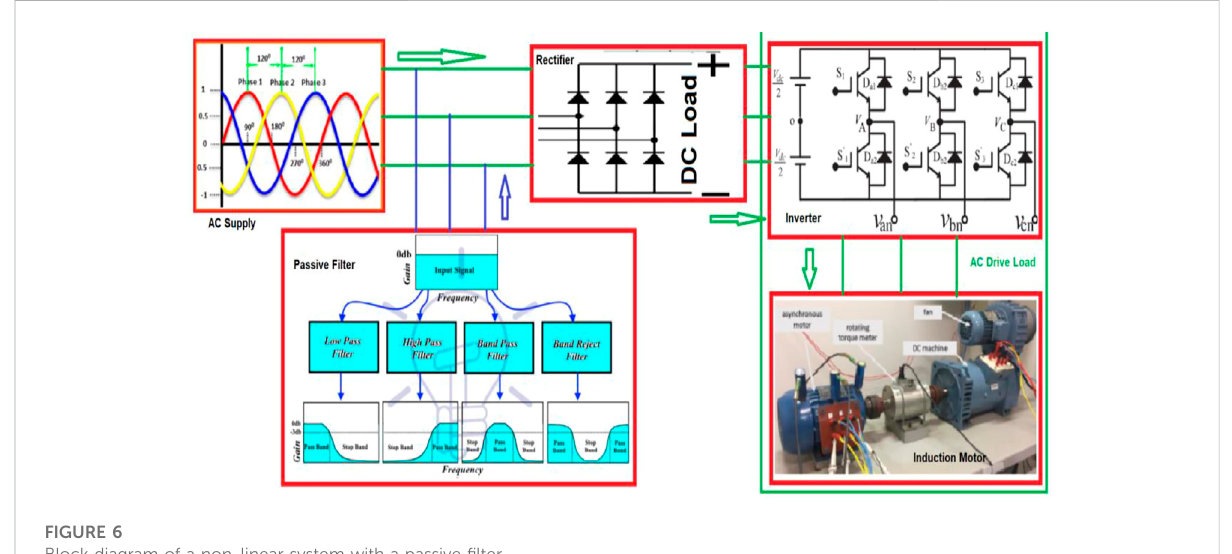
FIGURE 6 Block diagram of a non-linear system with a passive fi